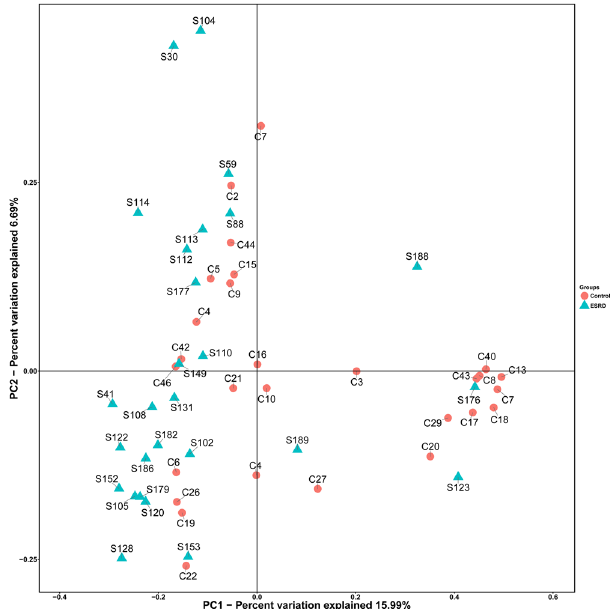
Figure 1. Principle Coordinate Analysis (PCoA) of gut microbiota from ESRD (Green) and healthy control (Red). The first two axes of the principal coordinate analysis are represented with principal coordinate axis 1 (15.99% variability) and principal coordinate axis 2 (6.69%